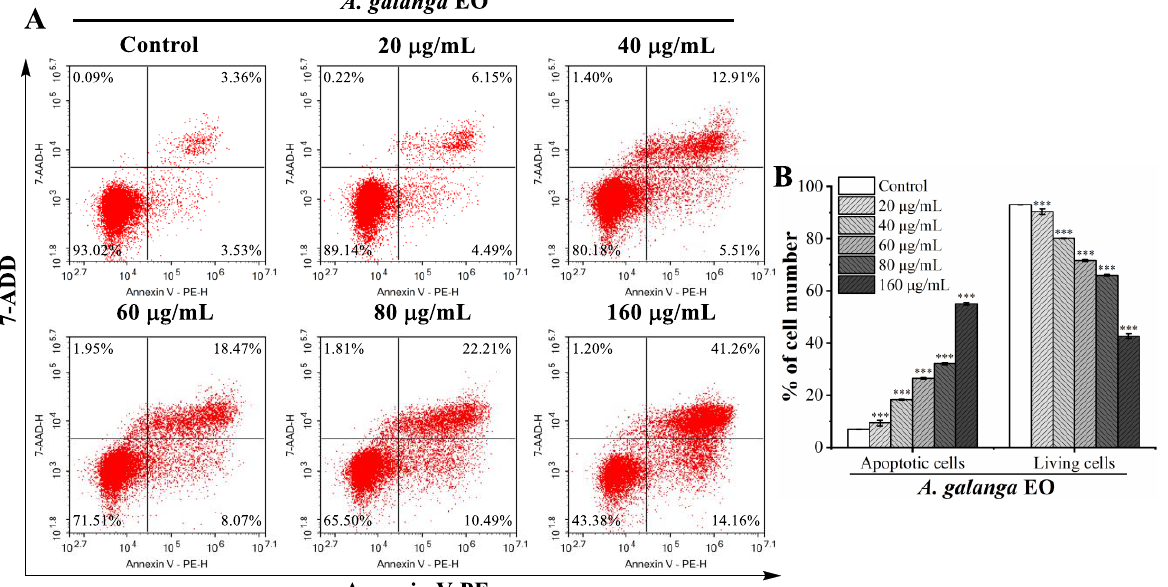
Figure 3. Flow cytometry apoptosis analysis of K562 cells treated with A. galanga flower essential oil. ( A ) K562 cells were labeled with Annexin V-PE and 7-AAD and then detected using flow cytometry. Cells in the upper-left quadrant (Q1-UL: Annexin V-PE–/7-AAD+): necrotic cells; upper- right quadrant (Q2-UR: Annexin V-PE+/7-AAD+): late apoptotic cells; lower-right quadrant (Q3-LR: Annexin V-PE+/7-AAD–): early apoptotic cells; lower-left quadrant (Q4-LL: Annexin V-PE–/7- AAD–): living cells. ( B ) Percentage of apoptotic cells and living cells. Results are presented as the mean ± SD. *** p < 0.001 versus the control